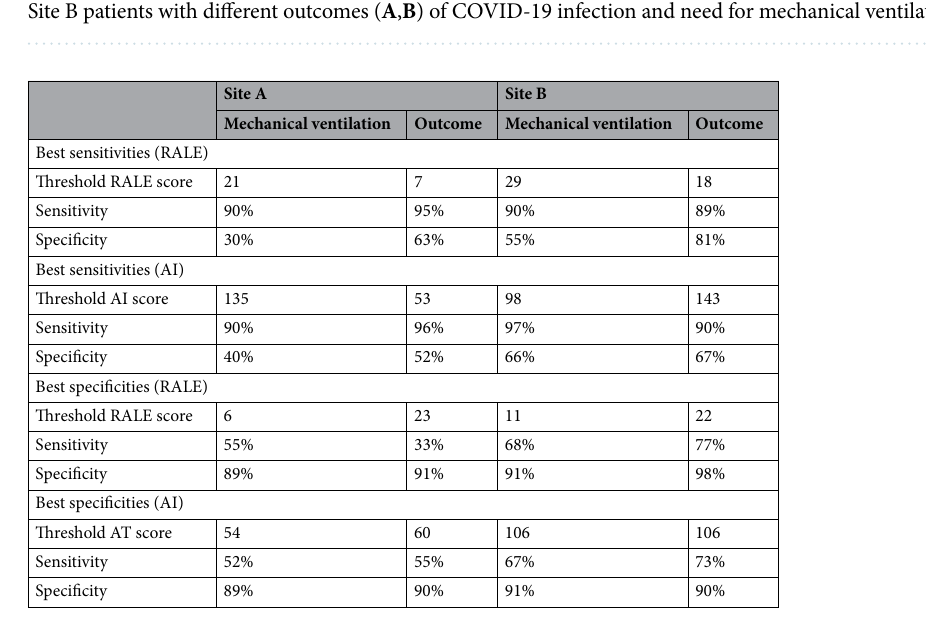
Table 5. Site-specific thresholds of RALE and AI scores with the best sensitivities and specificities for different outcomes.